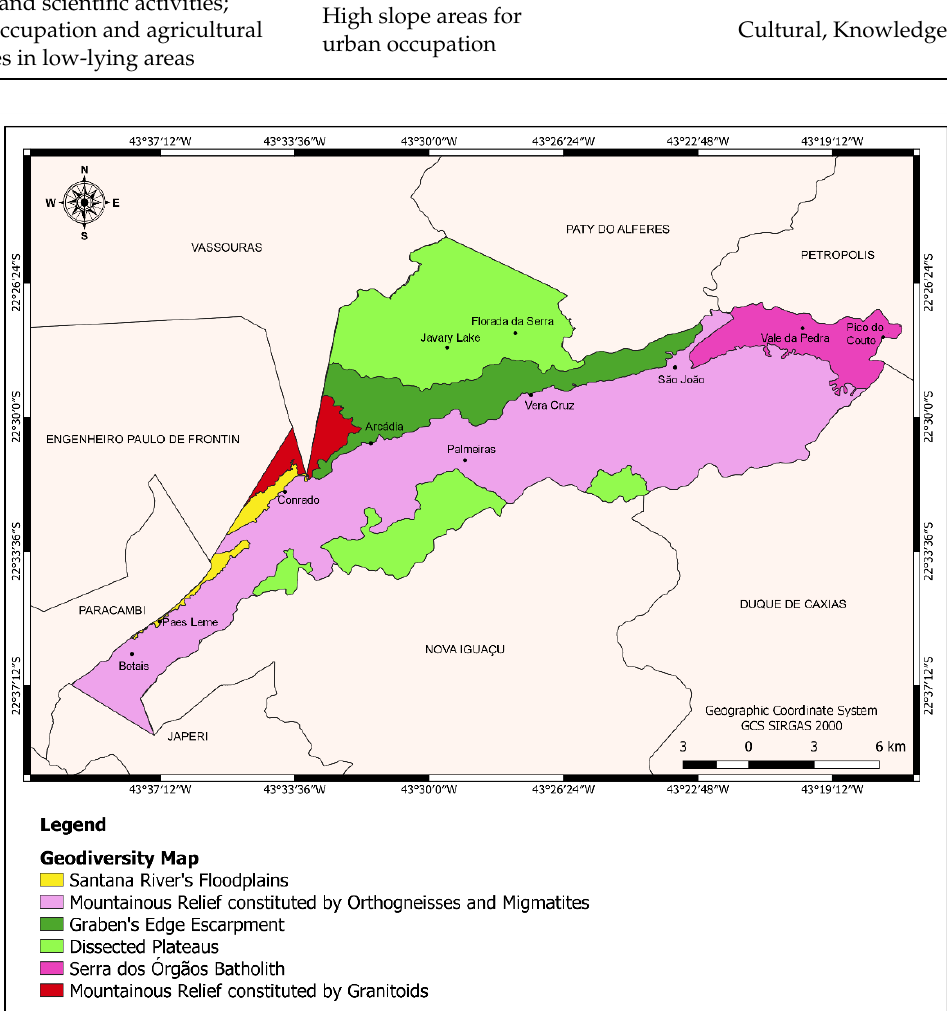
Figure 8. Geodiversity map of Miguel Pereira municipality, Rio de Janeiro State, Brazil. Table 2. Potentialities of and limitations to the use of the geodiversity units and their corresponding services.